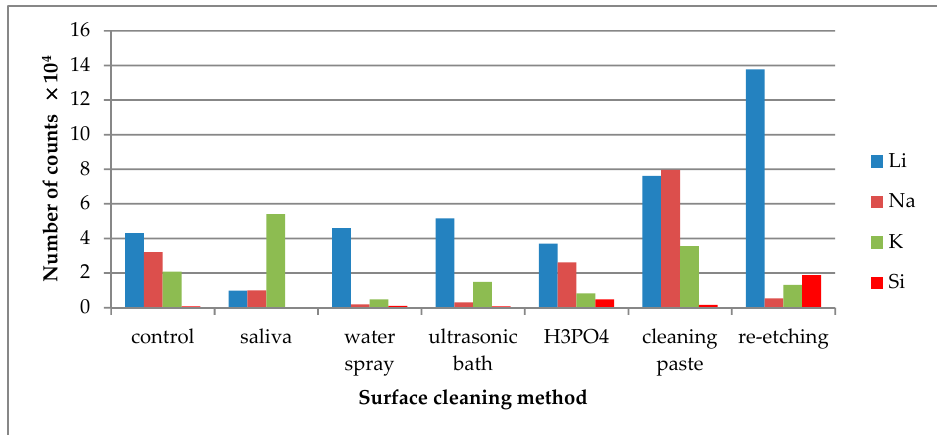
Molecules 2019 , 24 , 389